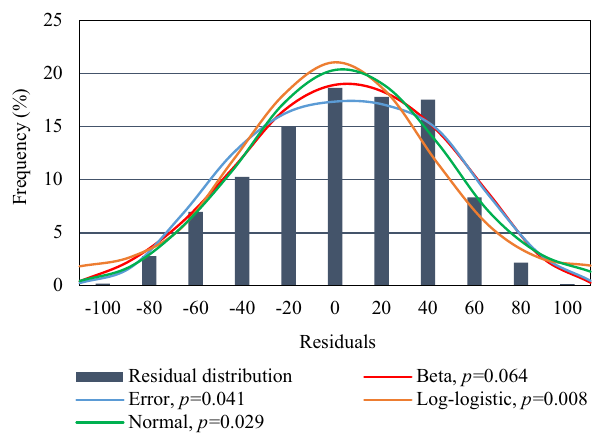
Fig. 5 Comparison of various common distributions with residual plot of obtained field data